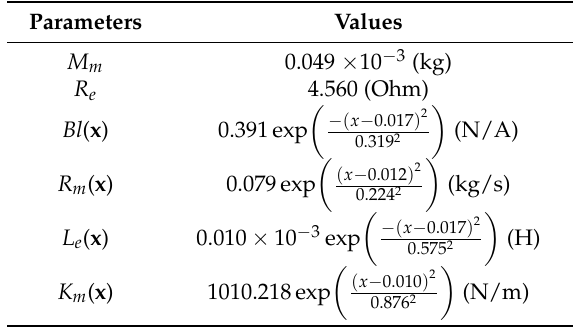
Table 1. Exact linear and nonlinear electroacoustic